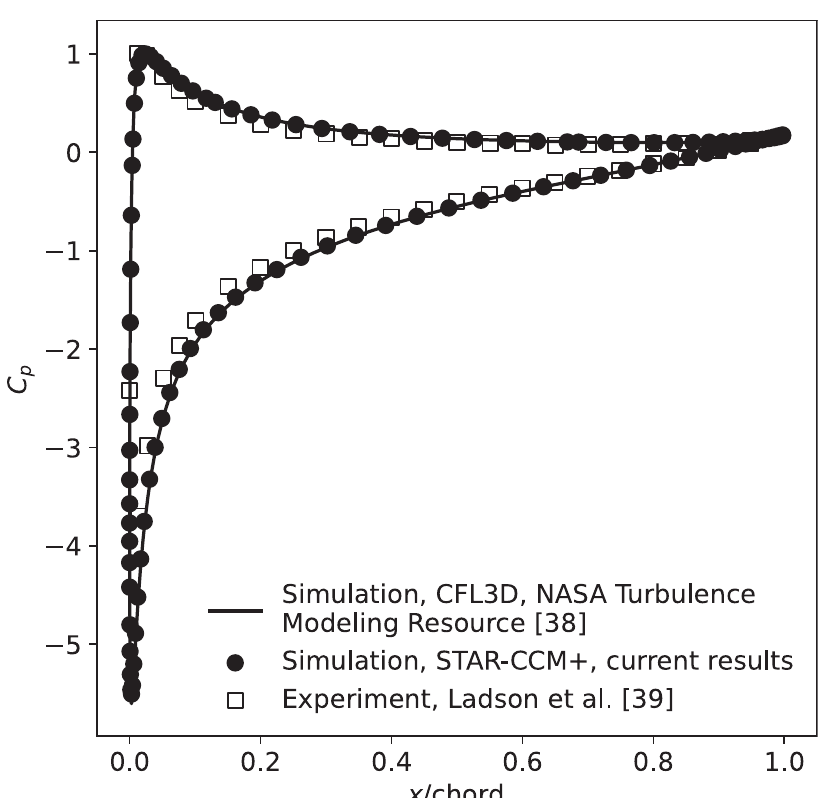
Fig 4. Comparison of the blade surface pressure coefficient, C p , for a NACA 0012 airfoil predicted in the current study using STAR-CCM+ compared with experimental results from Ladson et al. [39] and CFD results generated using CFL3D and a 897-by-257 computational grid [38]. All results are shown at a blade chord Reynolds number of 6 million.